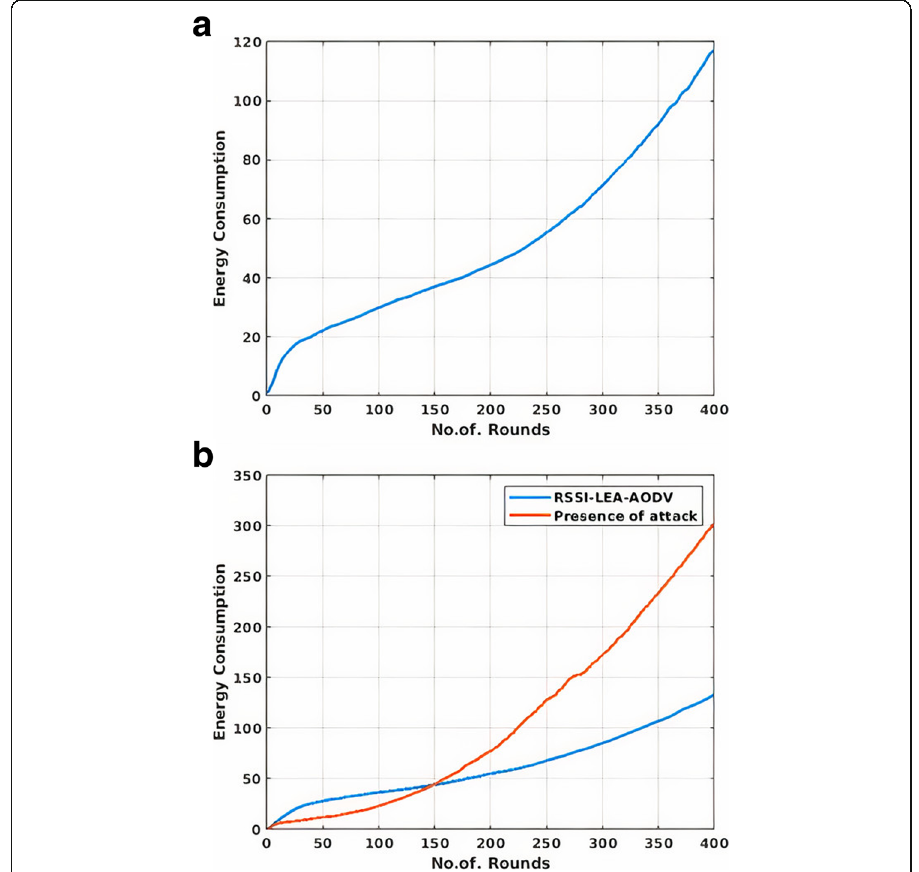
Fig. 12 a Energy consumption of the network without a Sybil attack. b Performance comparison of energy